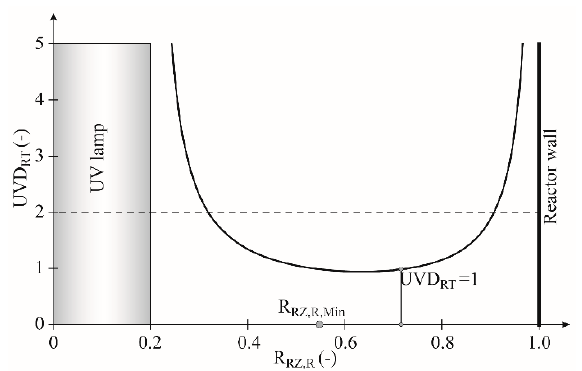
Figure 7. The relation between the UV radiation dose and the integral radius in the radiation zone.